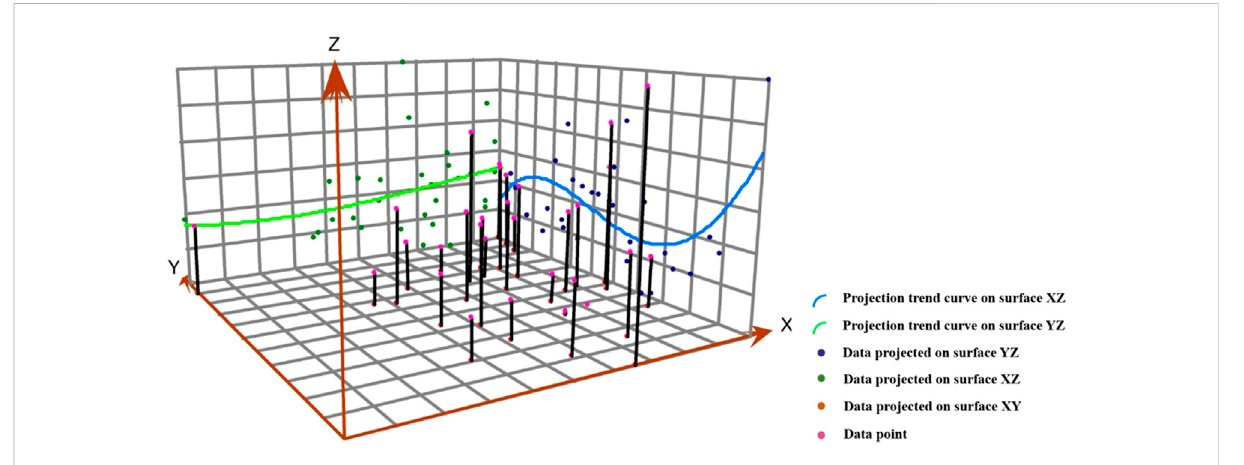
FIGURE 2 The spatial distribution pattern of China ’ s transportation GTFP in